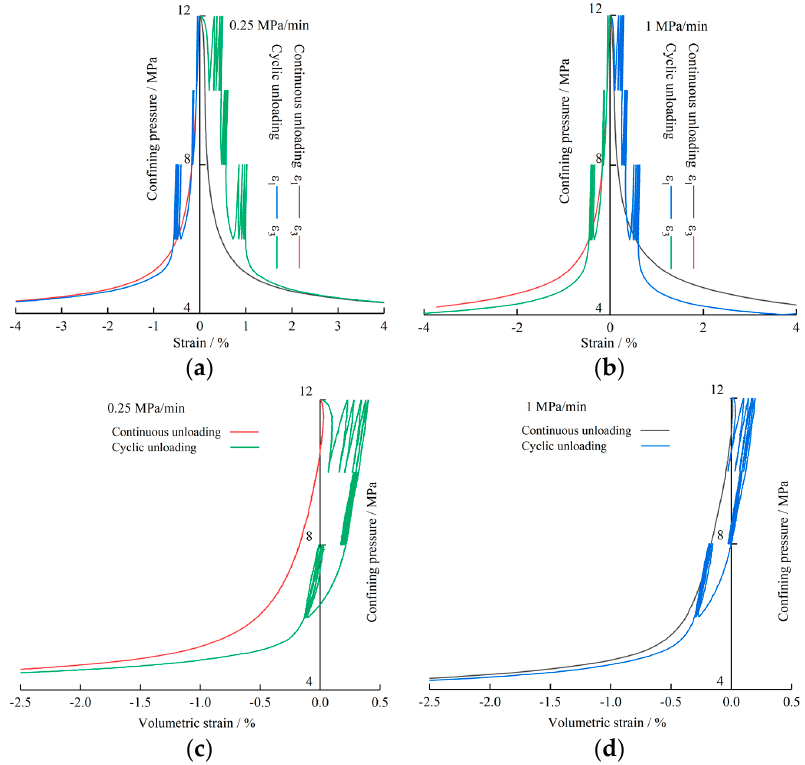
Figure 10. Stress–strain curves under different unloading path: ( a ) axial and radial strains of B-1 and C-1; ( b ) axial and radial strains of C-2 and C-2; ( c ) volume strain of B-1 and C-1; ( d ) volume strain of B-1 and C-2.